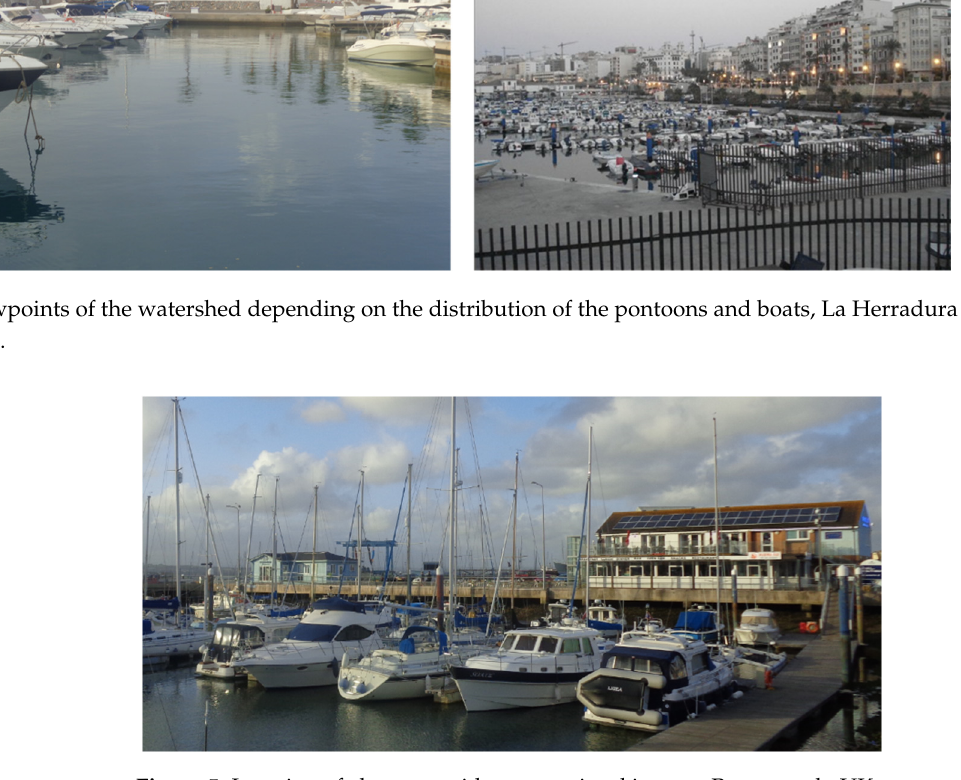
Figure 6. Location of elements with a great visual impact, Portsmouth, UK. Figure 5. Location of elements with a great visual impact, Portsmouth,